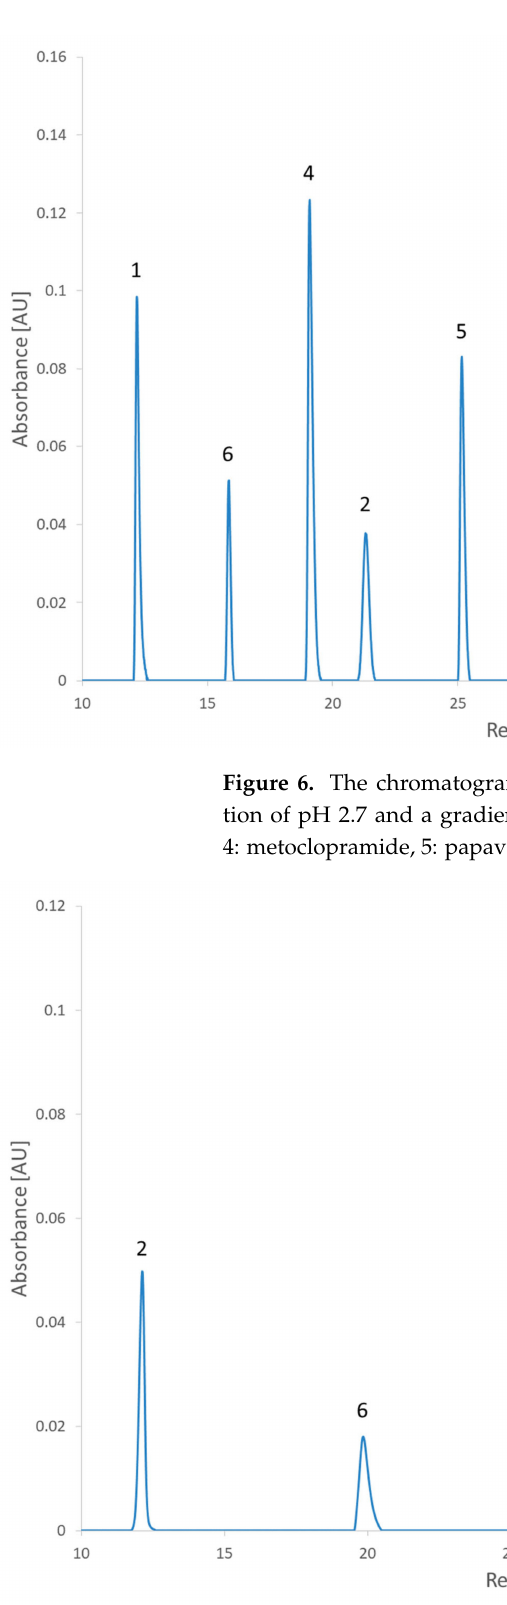
Figure 7. The chromatogram extracted at 210 nm of the second test set analyzed in the condi- tion of pH 7.0 and a gradient time of 50 min. 1: 2,2 (cid:48) -bipyridine, 2: 4-nitrophenol, 3: ibuprofen, 4: metoclopramide, 5: papaverine, 6: pindolol, 7: